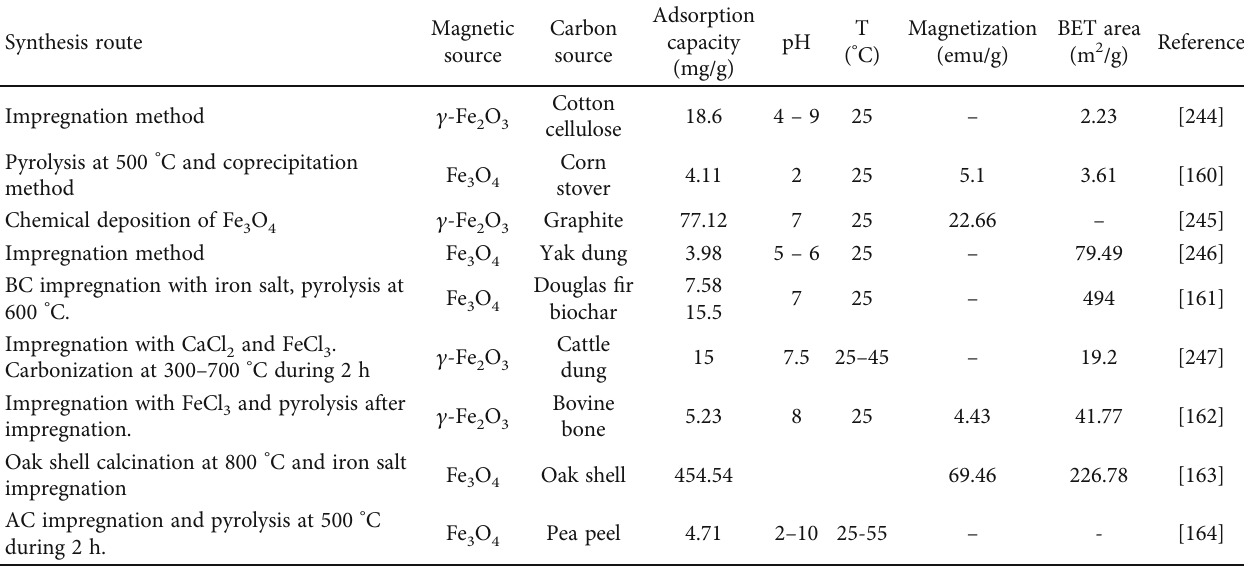
Table 5: Removal of fl uoride from aqueous solution using magnetic carbon-based adsorbents: preparation, removal operating conditions, and adsorption